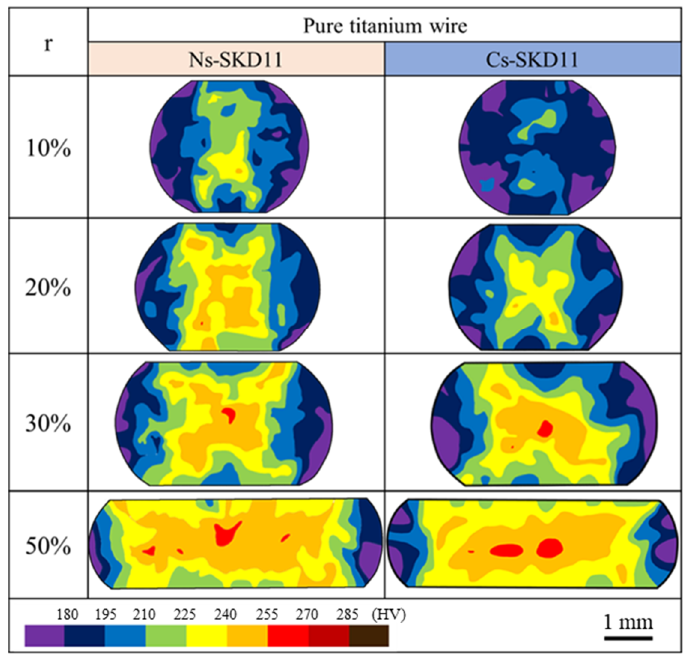
Figure 9. Comparison of the work-hardening behavior during the forging process of pure titanium wires between the Ns-SKD11 and Cs-SKD11 punches.